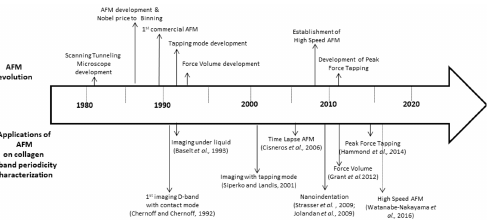
Figure 3. Time-line of AFM development and relevant techniques used for studying collagen D-band